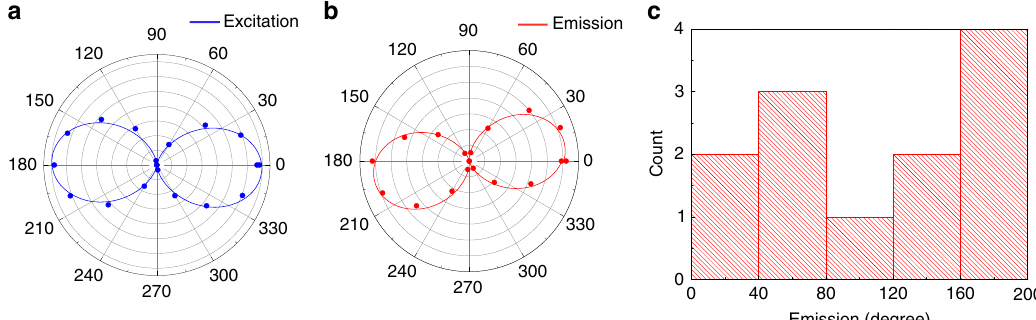
Fig. 4 Polarization of the SPEs. a , b The excitation (blue points) and emission (red points) polarization measurements from a SPE. Solid blue red lines are the fi tting with I = a + b sin 2 ( θ + ϕ ). c Summary of 12 emitters ’ emission